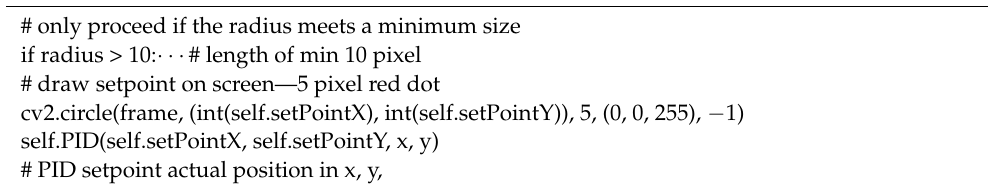
Algorithm 4. Fragment of the Python code: drawing setPoint on screen cv2.circle() and